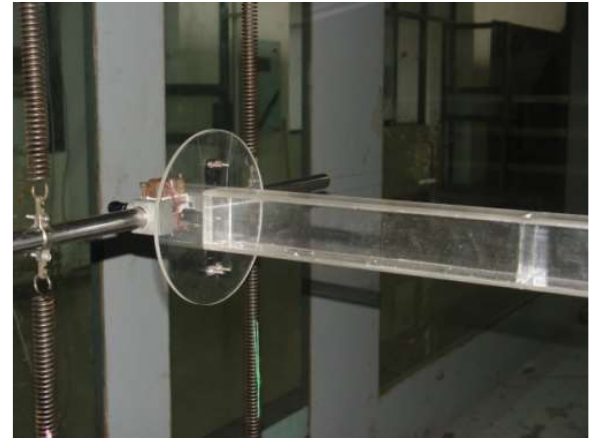
Figure 3. Section model setup.